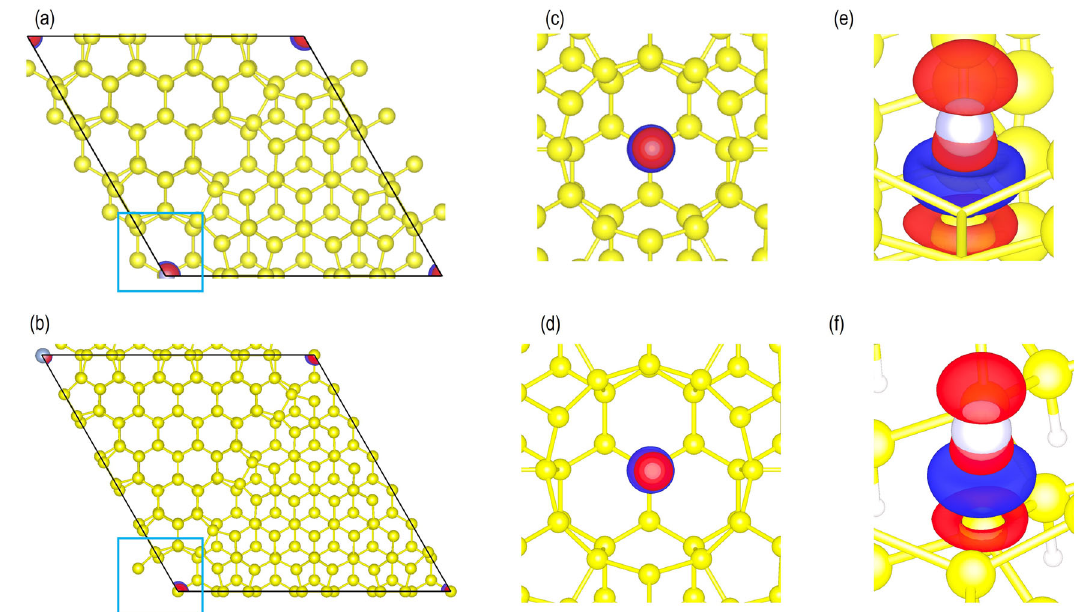
Fig. 6 Charge density difference of the Ag-adatom in the CH. The isosurface lobes (0.003 e/Å 3 ) of charge density difference of the Ag adatom adsorbed on ( a ) the Si(111)-5×5 and ( b ) the Si(111)-7×7 unit cell. The blue square shows the CH with the Ag adatom. The top view of the charge density difference on the CH of ( c ) Si(111)-5×5 and ( d ) Si(111)-7×7 unit cells. The side views of the enlarged charge density difference in the CH of ( e ) Si(111)-5×5 and ( f ) Si(111)- 7×7 unit cells. Red and blue lobe represents charge gain and charge depletion respectively. The yellow and light-blue balls represent Si and Ag atoms